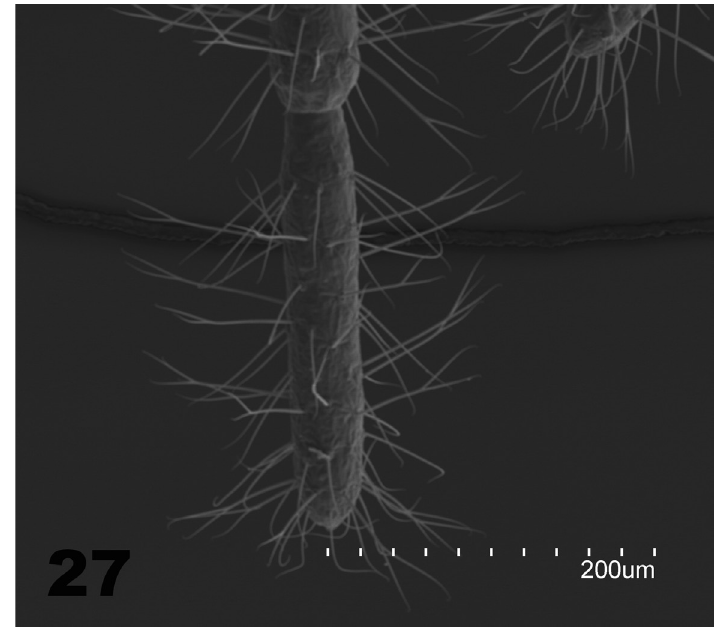
Figure 27. Haplocampa wagnelli Sendra, sp. n. Last primary cercal